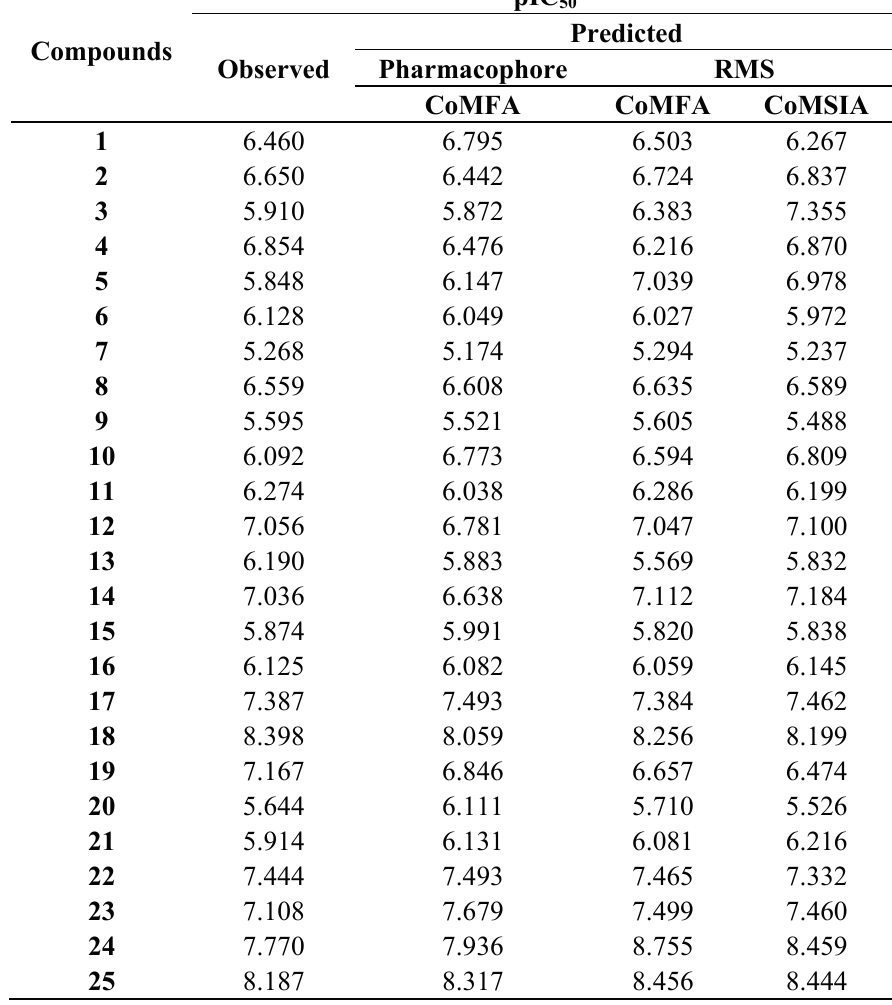
Table 1. The observed and predicted activities of 62 CYP11B1 inhibitors generated from different modeling